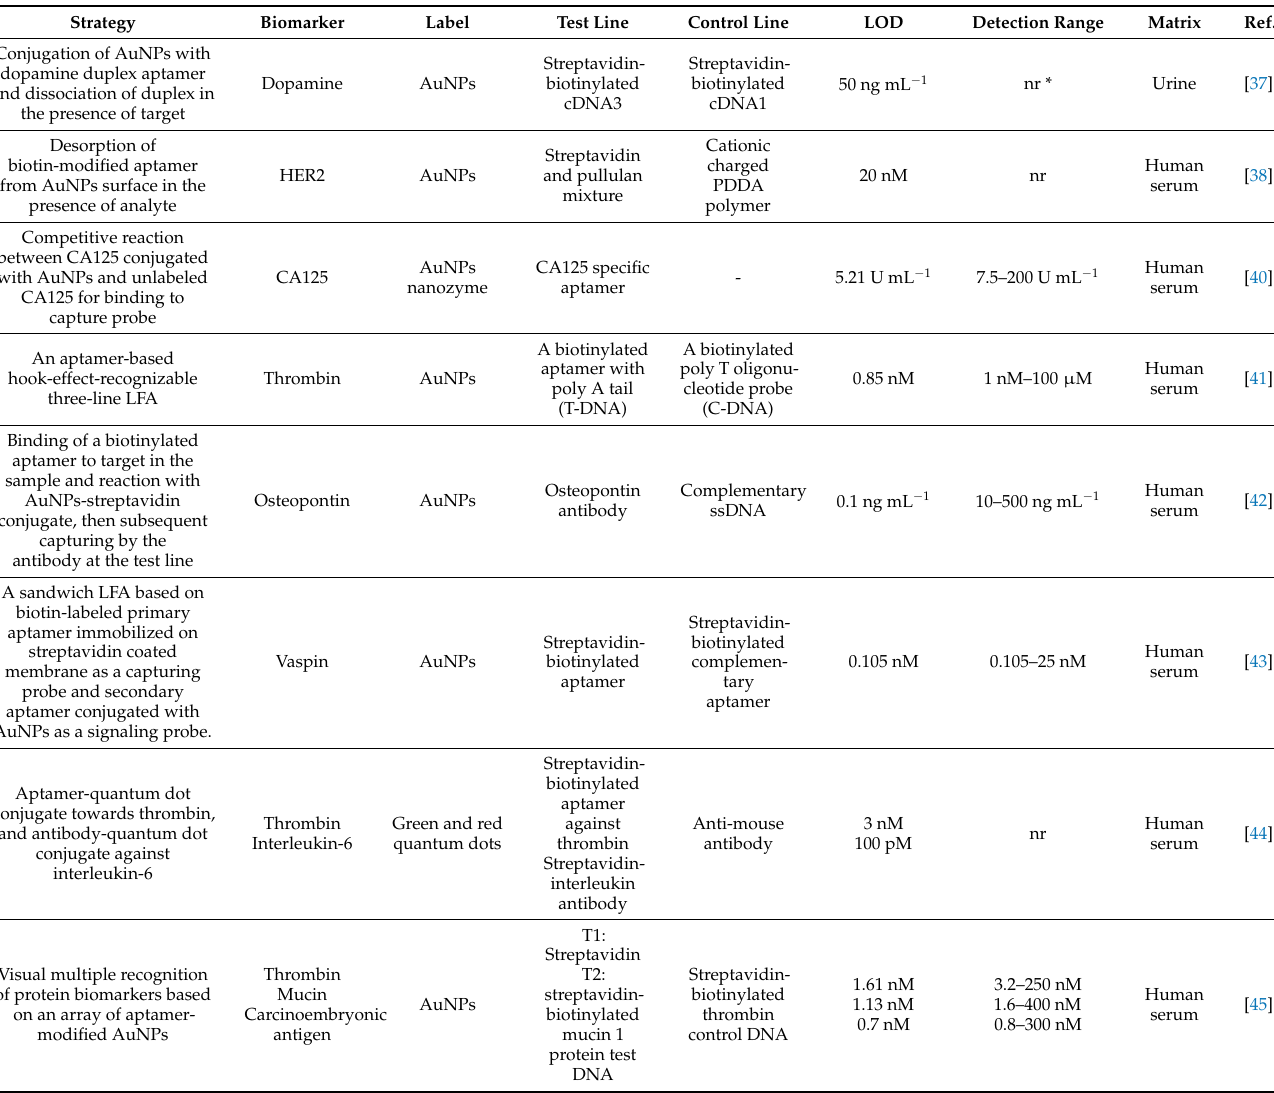
Table 1. Aptamer-based lateral flow assays for detection of